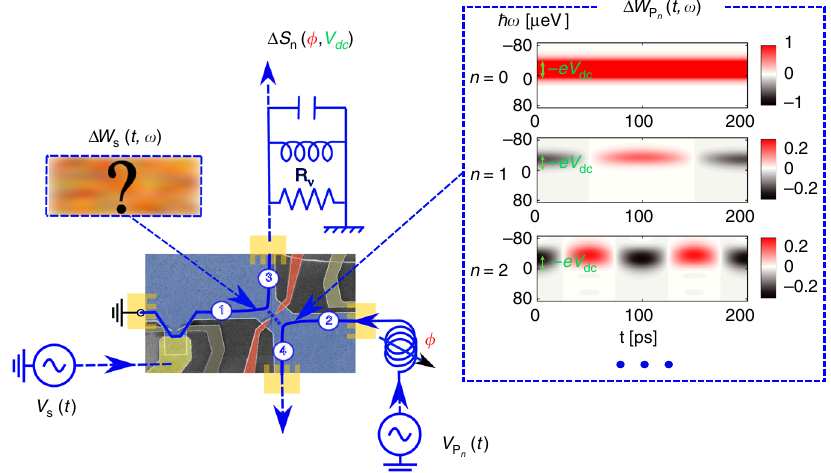
Fig. 2 Sketch of the experimental setup. The two-dimensional electron gas is represented in blue color and the edge channels as blue lines. A quantum point contact (red color) is used as an electronic beam splitter. A time-dependent voltage V S ( t ) is applied to a mesoscopic capacitor (gate in gold color capacitively coupled to the edge channel) placed at input 1 of the beam splitter and generates the unknown Wigner distribution Δ W S ( t , ω ). The probe ð t Þ , a low-amplitude sinusoidal drive at frequency nf is generated at input 2. The corresponding probe Wigner distributions Δ W signal V P n for n = 0 to n = 2 (the frequency is f = 5 GHz and the temperature T el = 80 mK). The current noise at the output of the splitter is converted to a voltage noise on the quantized resistance R ν = h /( ν e 2 ). R ν is connected to an LC tank circuit used to shift the measurement frequency at the resonance f 0 =